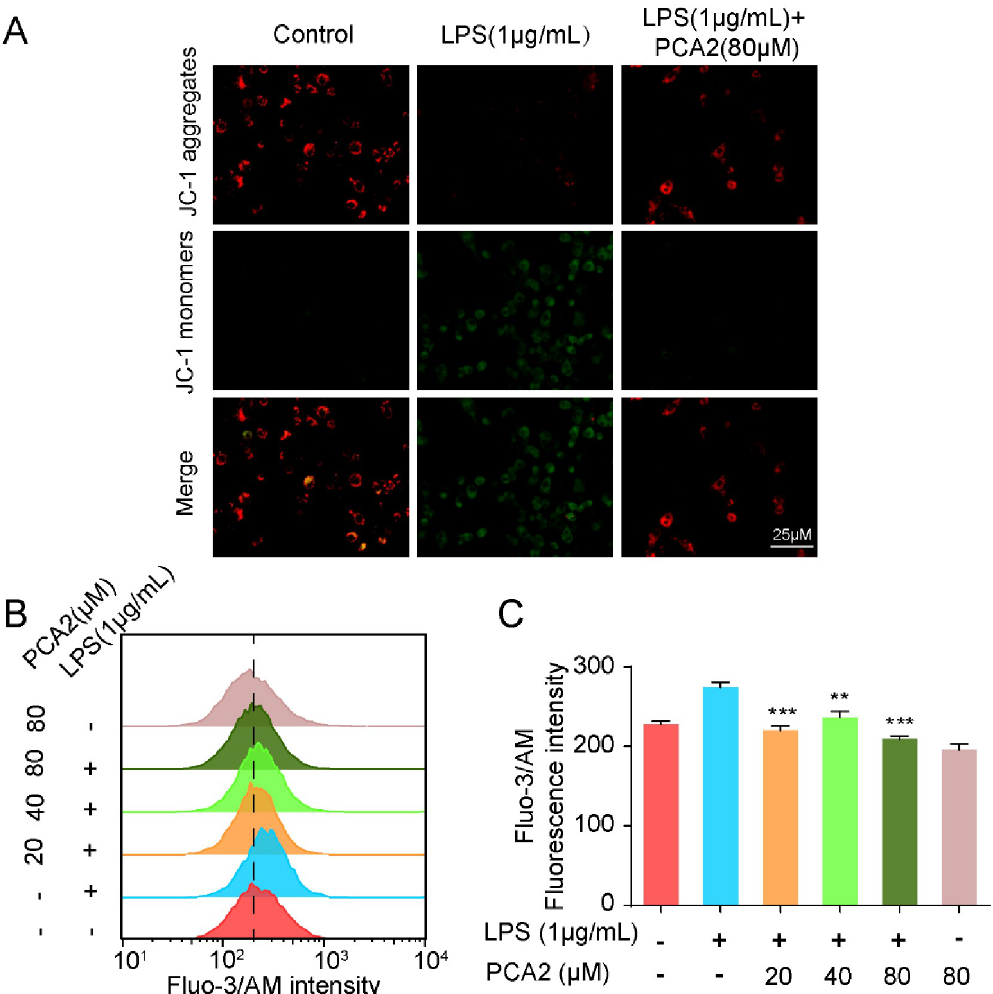
Fig 4. PCA2 reversed LPS-induced mitochondrial-membrane-potential (MMP) loss and calcium influx. (A) The cell was exposed to PCA2 (80 μ M) for 1 h and cultured with LPS for 8 h, except for the control group. For the measurement of MMP, JC-1 (10 μ g/mL) was loaded for 0.5 h and images were acquired with a fluorescence microscope (n = 3). (B) Cells were co- cultured with LPS for 6 h before treated with PCA2 (20, 40, 80 μ M) for 1 h, except the control group and only treated with PCA2 group. After cells were incubated with Fluo-3/AM (1 μ M) for 1 h, collected to flow tube and monitored by the flow cytometry (n = 3). ( C ) Statistical analysis of the fluorescence intensity of Fluo-3/AM (n = 3). �� p < 0.01, ��� p < 0.001 vs. LPS